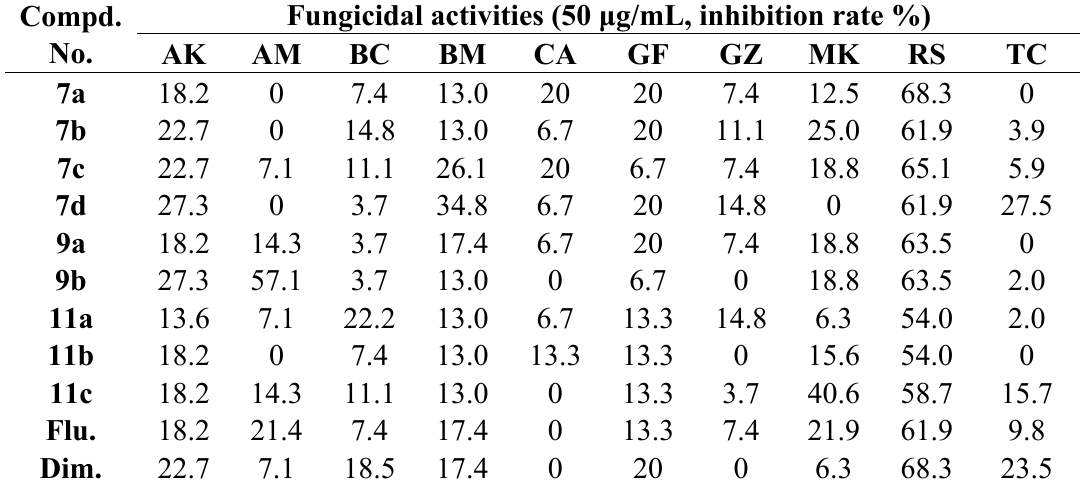
Table 3. The antifungal activities of 7 , 9 and 11